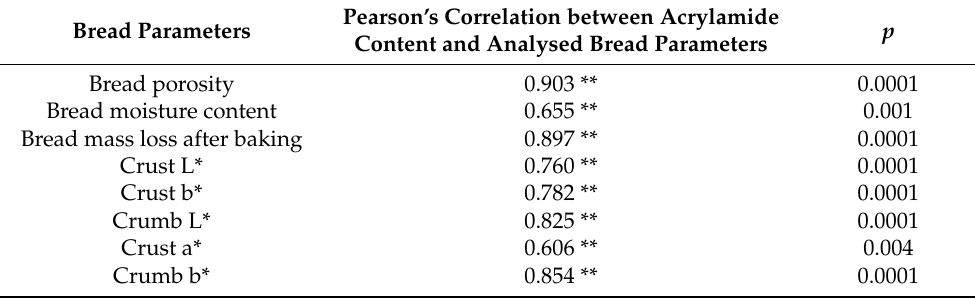
Table 9. Correlation between acrylamide concentration in bread samples and bread parameters. Pearson’s Correlation between Acrylamide p Bread Parameters Content and Analysed Bread Parameters Bread porosity 0.903 ** 0.0001 Bread moisture content 0.655 ** 0.001 Bread mass loss after baking 0.897 ** 0.0001 Crust L* 0.760 ** 0.0001 Crust b* 0.782 ** 0.0001 Crumb L* 0.825 ** 0.0001 Crust a* 0.606 ** 0.004 Crumb b* 0.854 **